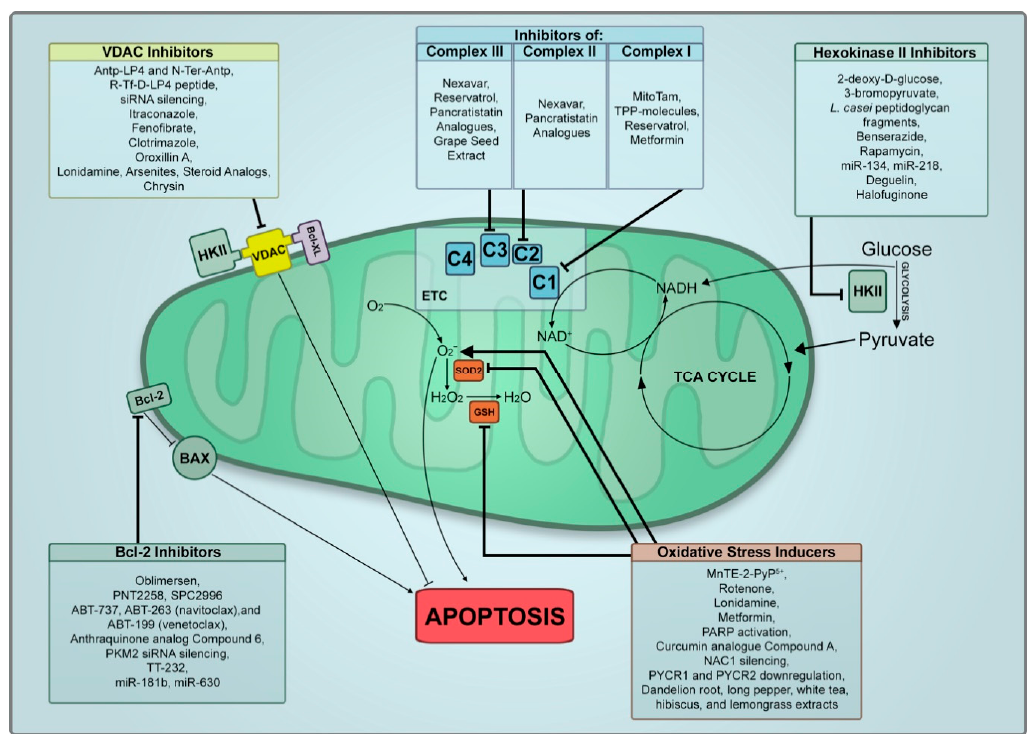
Figure 1. Mitocan treatments and mitochondria targets. Summary of reviewed mitocan treatments and their targets in the mitochondria. HKII, hexokinase II; C1, complex I; C2, complex II; C3, complex III; C4, complex IV; ETC, electron transport chain; VDAC, voltage-dependent anion channel 1; TPP, triphenylphosphonium; PARP, poly (ADP-ribose) polymerase; NAC1, nucleus-accumbens-1; PYCR, pyrroline-5-carboxylate reductase.